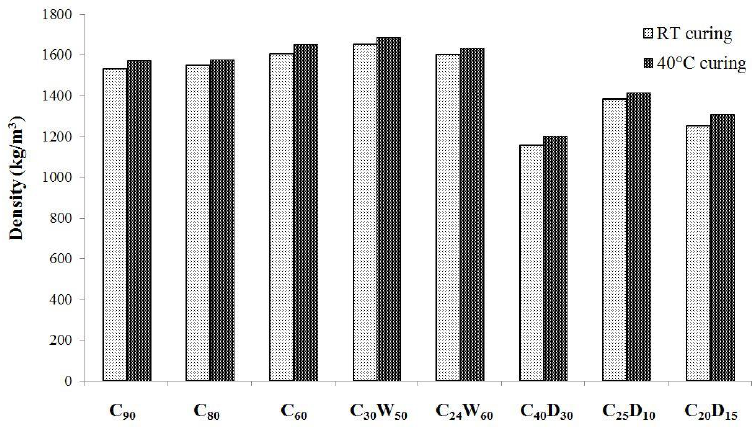
Figure 8. Dry density of artificial aggregates.